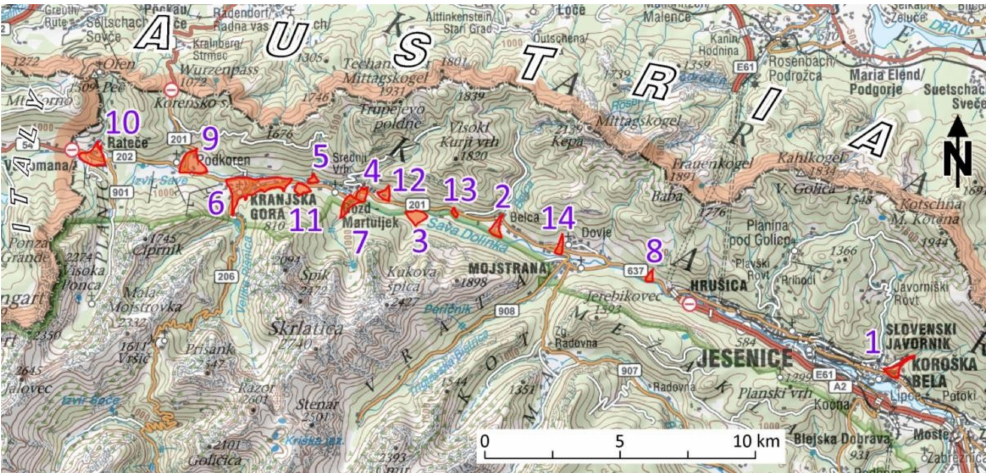
Figure 2. Location of 14 alluvial (torrential) fans (red areas) occurring in the upper part of the Sava river valley in NW Slovenia (courtesy of © Surveying and Mapping Authority of the Republic of Slovenia).